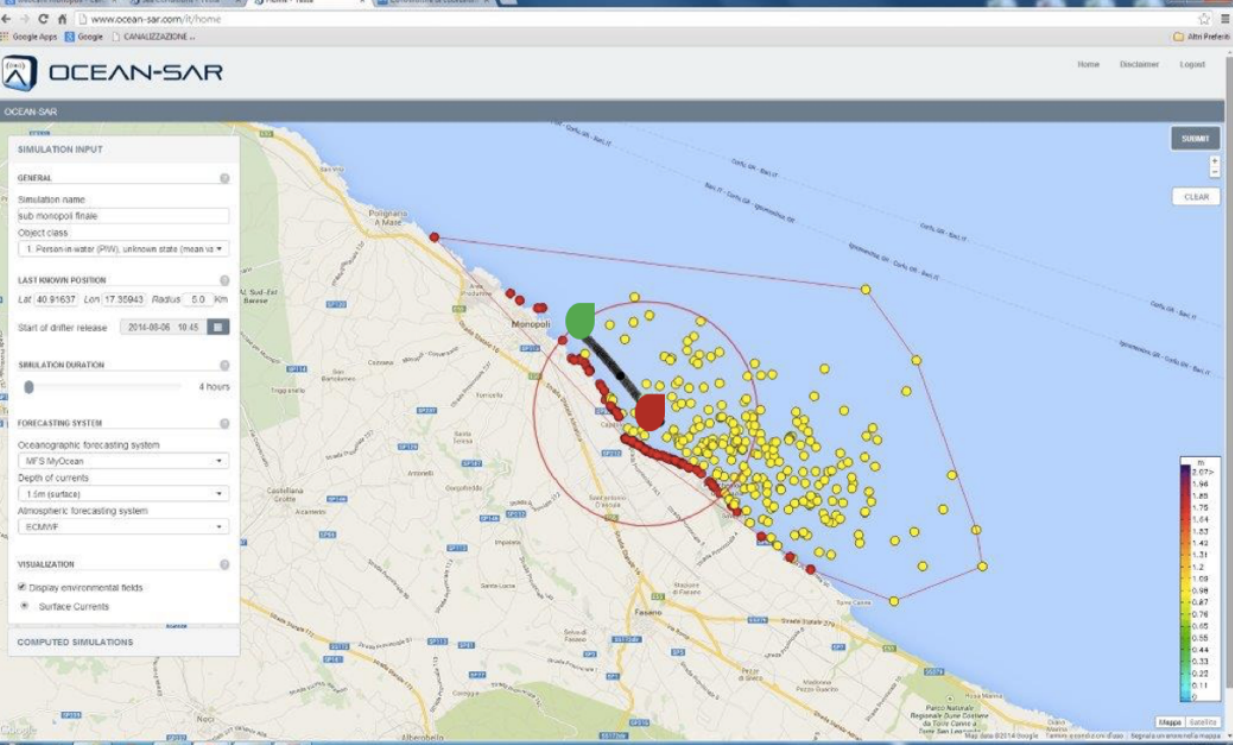
Figure 16. Results of the real case scenario called MONOPOLI; the simulation was done using OCEAN-SAR showing the positions (yellow points and red points on the coast) of the particles at the end of the simulation 14:45UTC on 6 August 2014. The large red place marker indicates the position in which the person was found at sea after 4h. The green point represents the last known position at which the diver was lost at 10:45UTC of 6 August